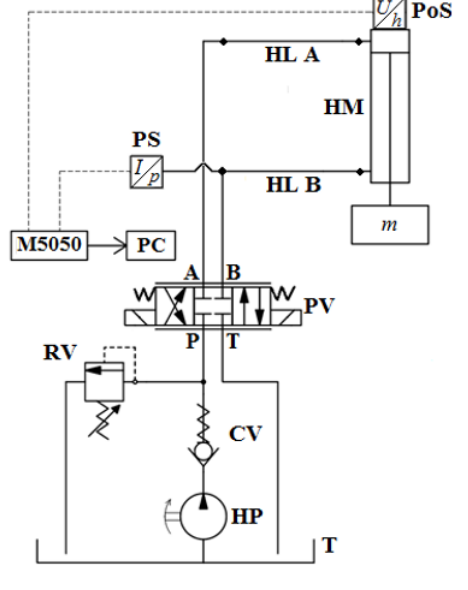
Fig. 1. Scheme of experimental circuit .